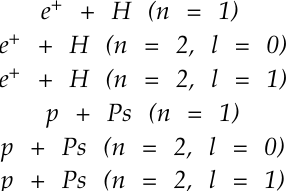
Table 1. Faddeev channel parameters [22], lengths in Bohr Radius.